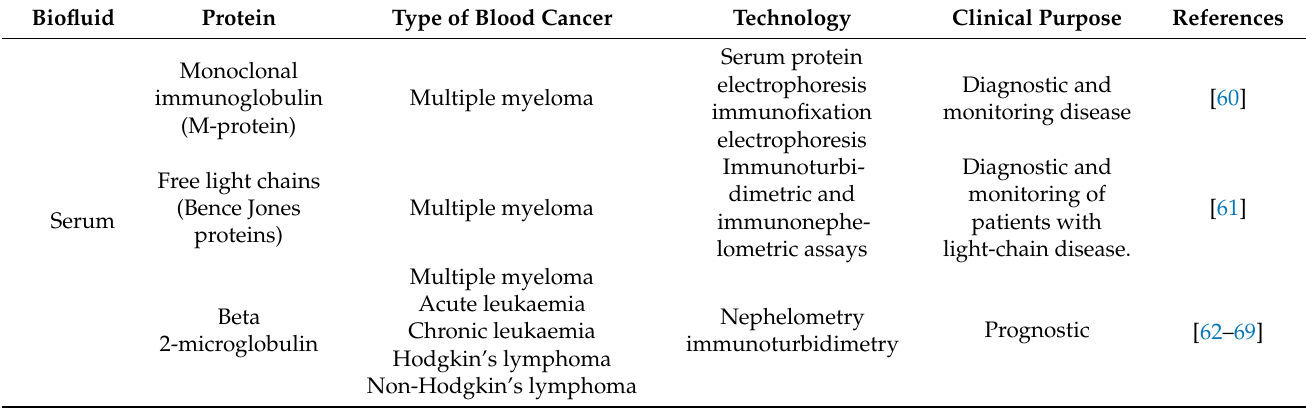
Table 2. Current clinically used protein biomarkers in haematological malignancies. Biofluid